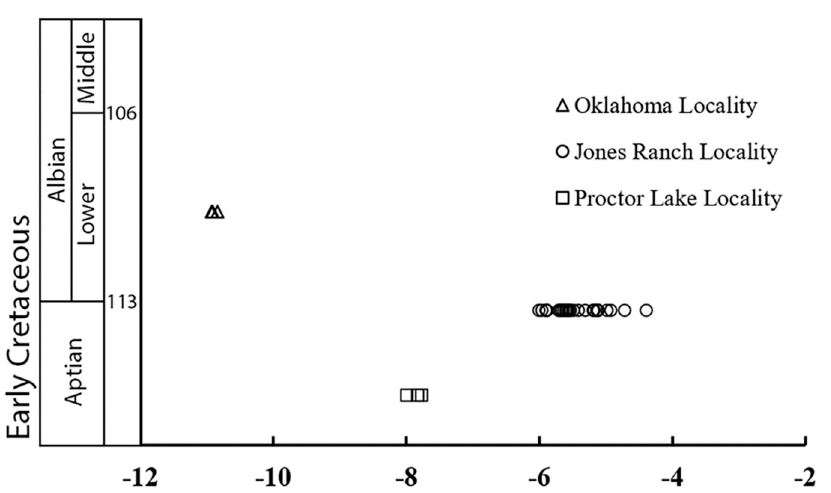
Figure 3. A plot of the δ 13 C values of pedogenic calcite from Lower Cretaceous localities in Texas and Oklahoma. The data represent both the initial and replicate analyses conducted on samples from each locality.